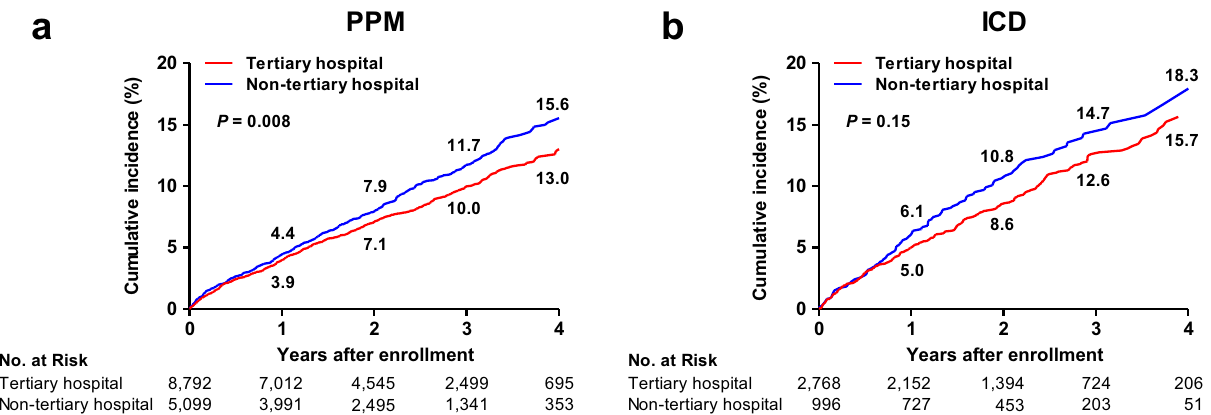
Figure 2. Unadjusted cumulative incidence rates for all-cause deaths in the study population. Cumulative incidence curves are shown for all-cause death in patients with PPM group ( a ) and in those with ICD group ( b ). The numbers in each figure represent the cumulative incidence rates at each time point. All p values were calculated with the use of the log-rank test. ICD, implantable cardioverter-defibrillator; PPM, permanent